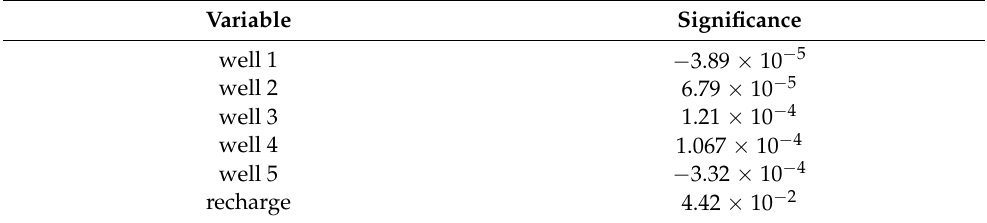
Table 4. The significance of each predictor variable coefficient based on the lasso shrinkage